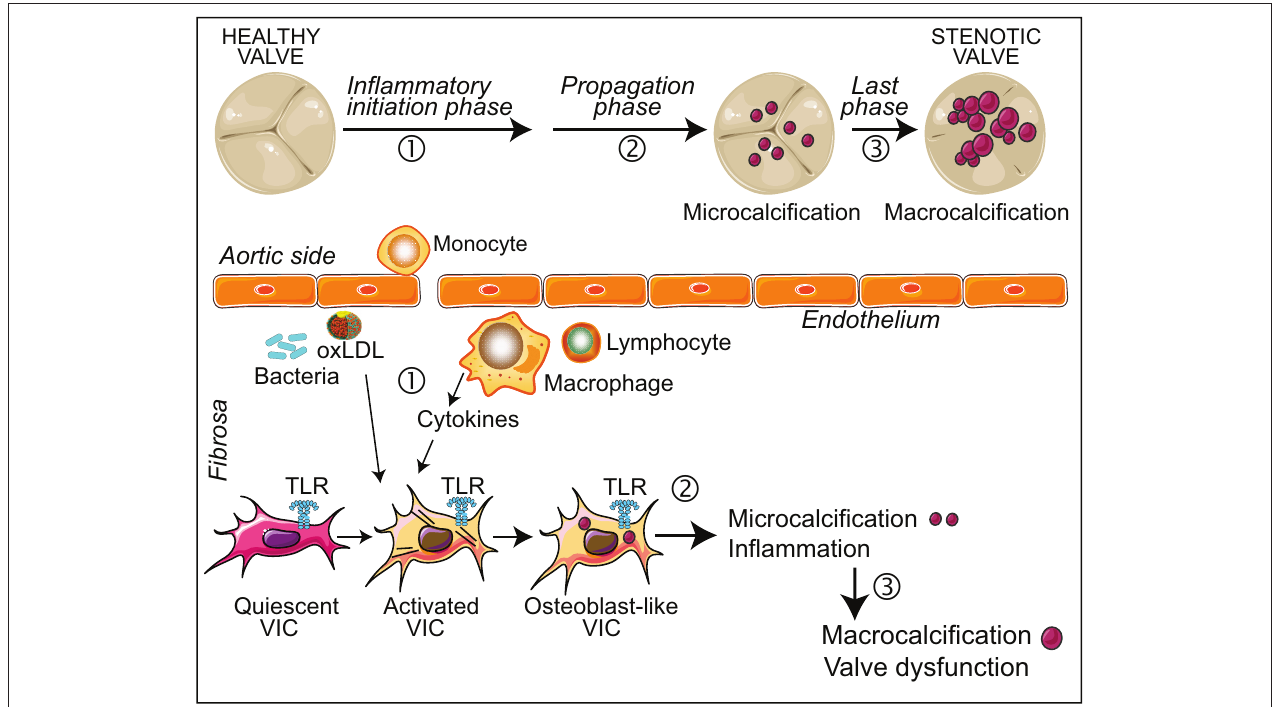
FIGURE 2 | Inflammation in CAVD progression. The scheme shows the role of inflammation in the different stages of CAVD, at both valve and cellular levels. (1) Valve endothelial layer disruption leads to the recruitment of immune cells and oxLDL. This inflammatory milieu promotes the activation and differentiation of quiescent VIC. These cells express functional TLR, the activation of which induces inflammation and osteogenic reprogramming. (2) In the propagation phase, inflammation promotes the development of microcalcifications. (3) Large scale calcification leads to leaflet thickness and valve dysfunction.